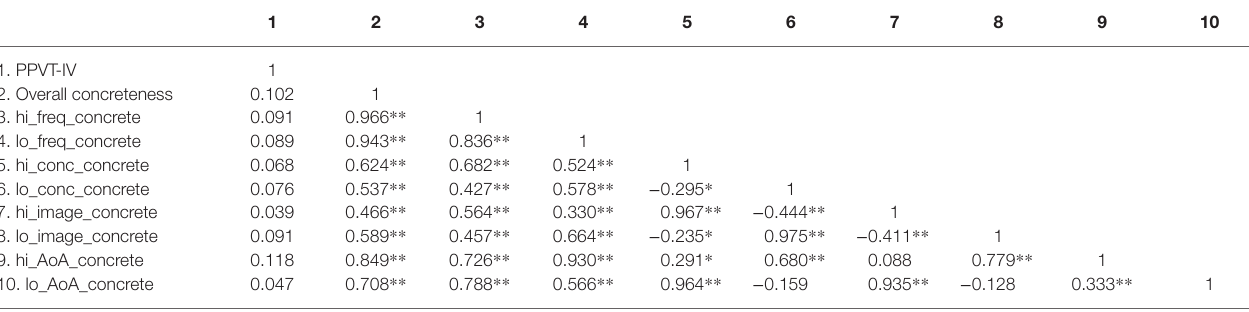
TABLE 3 | Correlation between PPVT-IV and main and subscores of concreteness ratings.